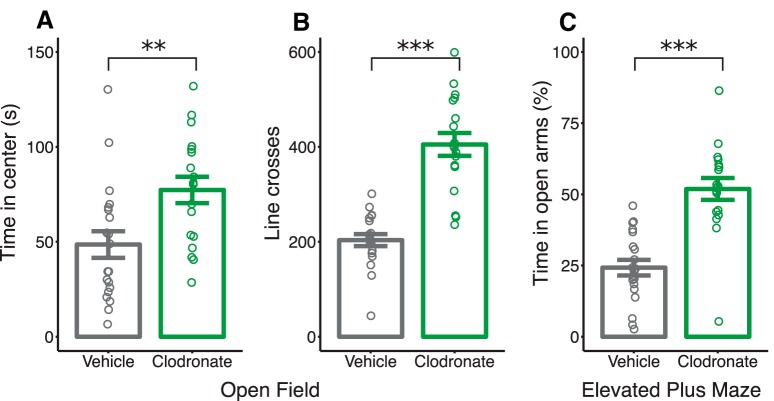
Postnatal microglia depletion increases locomotion, center time in the open field, and open arm time in the elevated plus maze in juvenile rats. Center time (a; in seconds) and gridline crosses (b) in an open field arena on PN25. c, Percentage of time in the open arms of an elevated plus maze on PN32. Bars indicate group means ± SEM for VEH-treated (black) and LC-treated (green) rats of both sexes. Open circles represent data from individual rats. **p < 0.01, ***p < 0.001. n = 18–20 per treatment.